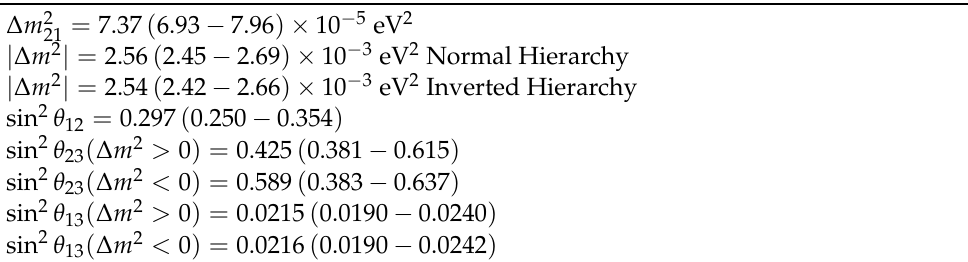
Table 2. Mixing and squared mass differences as they appear in [141]. Error values in parentheses are shown in 3 σ interval. The squared mass difference is defined as ∆ m 2 = m 2 its sign depends on the hierarchy m 1 < m 2 < m 3 or m 3 < m 1 < m 2